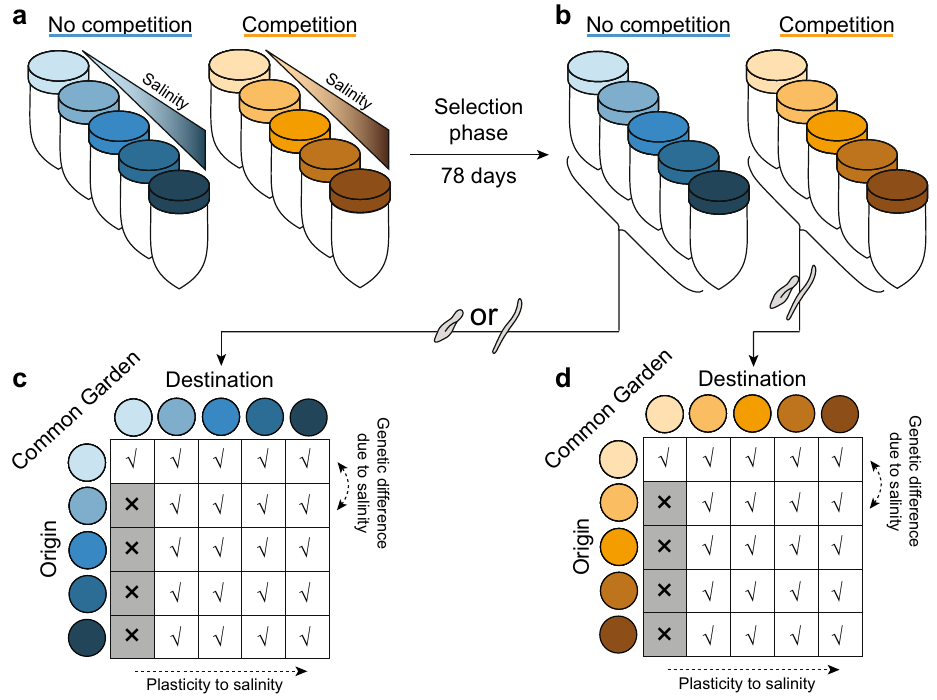
Figure 1. Experimental set-up. ( a ) During the selection phase, populations of all species were kept in five different environmental conditions (represented by color shades) either in absence (blue colors) or presence (orange colors) of competing species (each threefold replicated). ( b ) End of the selection phase. Change in trait means from ( a ) to ( b ) reflect the phenotypic temporal response to salinity and competition. ( c , d ) Common garden experiment in which aliquots of the populations of all species evolved in the absence ( c ) and presence ( d ) of competition are placed in a common salinity environment, respectively. In this study, for the competition treatment an aliquot of the end point of the selection phase was used in the common garden. Comparing trait means between ( c ) and ( d ) shows whether the response to salinity depends on the competition and salinity condition the species was selected